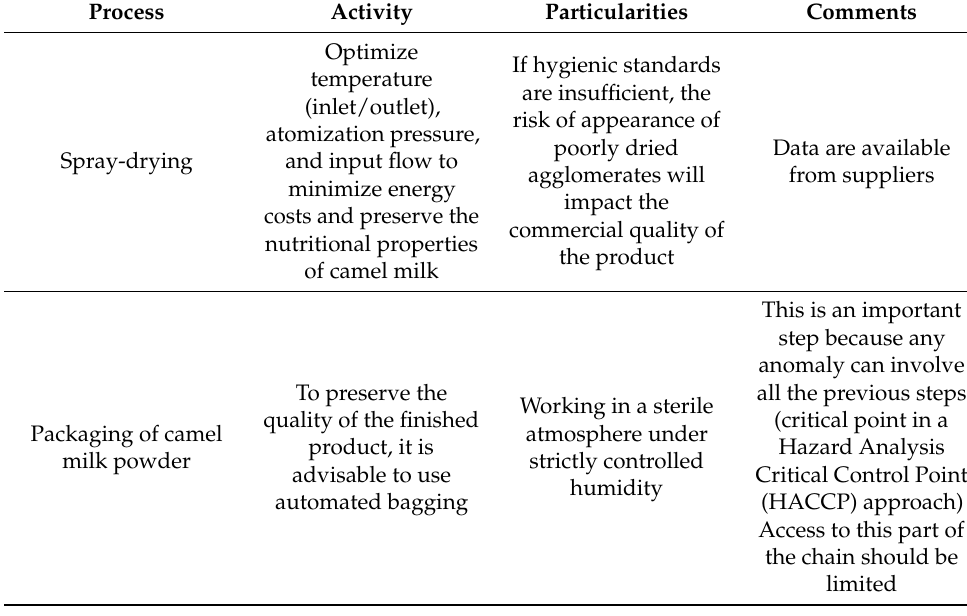
Table 3. Cont. Process Activity Particularities